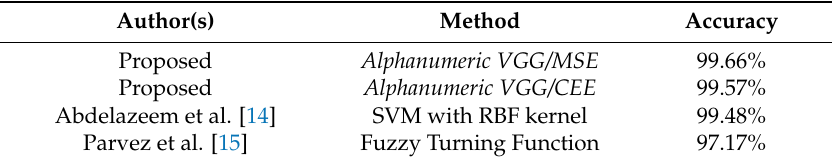
Table 5. Comparison with state-of-the-art methods on the ADBase database.